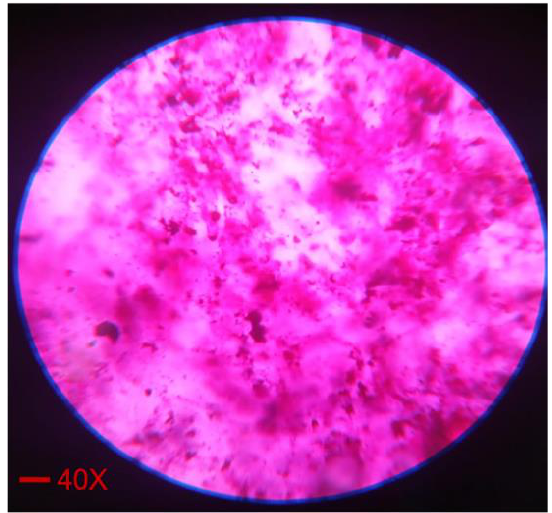
Figure 3. Microscopic image (F1 formulation) indicating the solubility of amaranth in the continuous phase at 40 × .